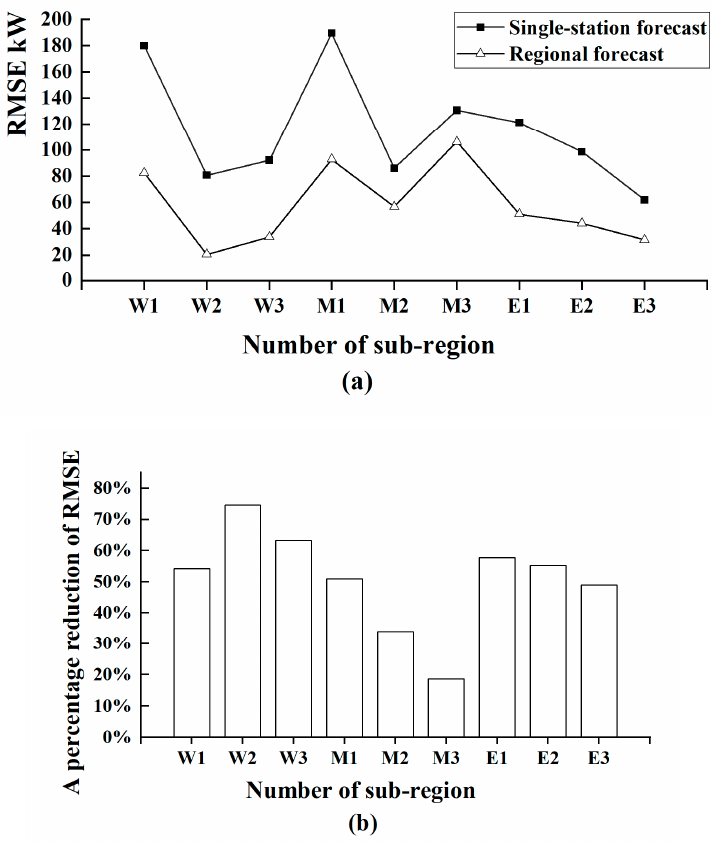
Figure 5. Forecast results based on large-area partition ( a , b ).